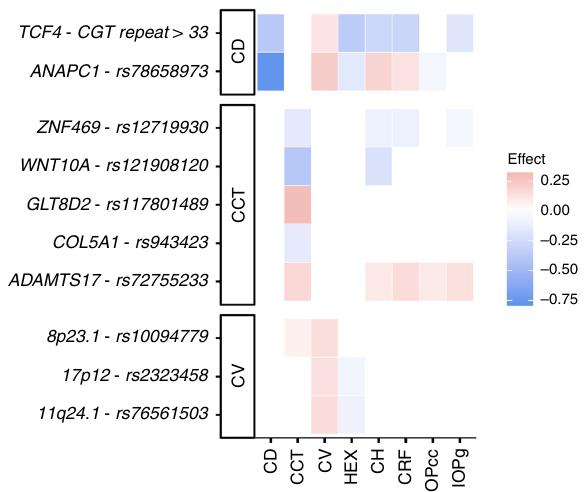
Fig. 3 Effects of the GWS corneal structure variants on different corneal measures. Each row shows the estimated effect of the minor allele on the corneal measures from the specular microscopy and the ocular response analyzer. The variants are annotated with their corresponding gene and grouped by their strongest associating trait. The effect is shown only for signi fi cant associations after adjusting for multiple testing with a false discovery rate procedure for each variant. Red color represents a positive effect on the corneal measures and blue color represents a negative